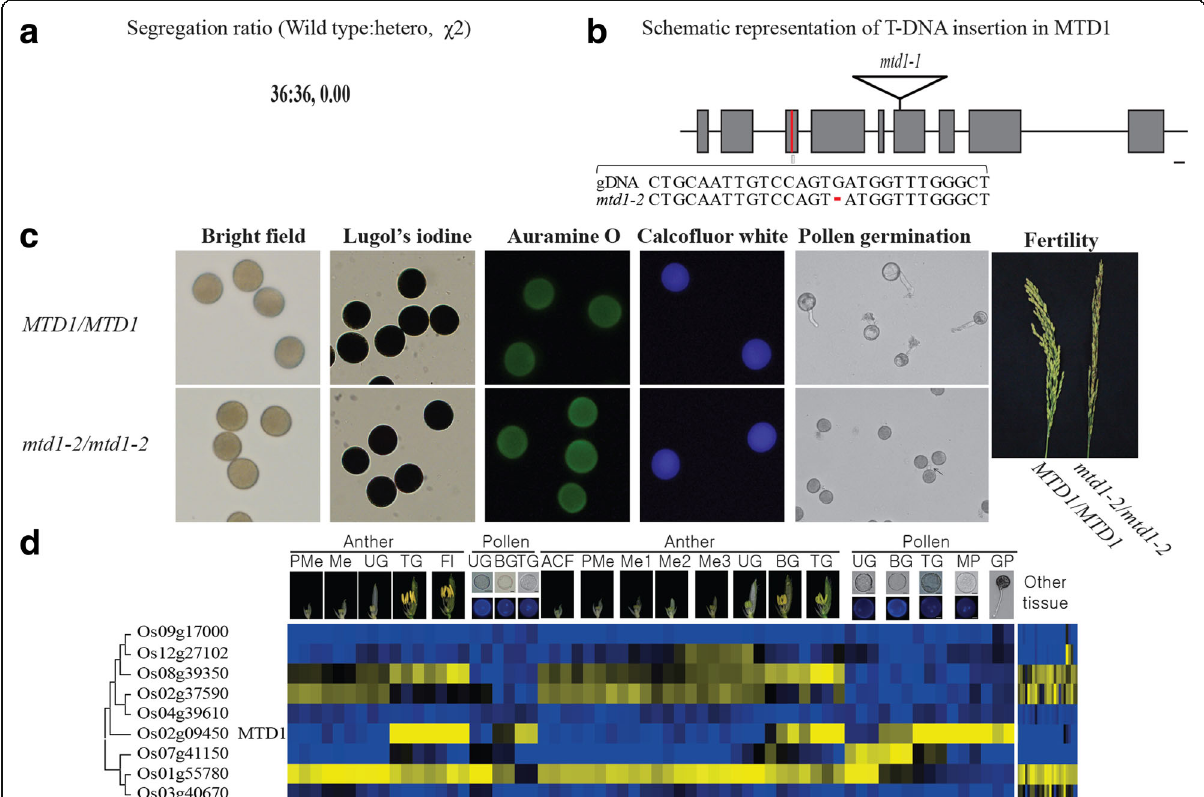
Fig. 6 Estimation of functional dominancy by MTD genes through phylogenomic analysis ( a ) segregation ratios of heterozygotes and wild-type segregants in mutants of MTD1 by T-DNA insertion, and results of Chi-square test ( χ 2 ). b Schematic view of MTD1 structure and mutated position by T-DNA insertions and deletion generated by CRISPR/Cas9. Grey boxes indicate exon; lines, UTR or intron; reverse triangles, T-DNA; red box, target region of CRISPR/Cas9. Genomic DNA sequences from wild type and gtd1 – 2 are shown. c Phenotypes of pollen grains from wild type and mtd1 – 2 . Germinated pollen and grains stained with Lugol ’ s iodine, auramine O, or calcofluor white were observed under bright field and fluorescence microscopes. Bar=20 μ m. Panicles at filling stage of wild type and mtd1 – 2 were observed. d Expression patterns according to developmental stages of pollen were analyzed using 22 microarray data from indica rice (5 stages for anthers, 3 for pollen) and 42 microarray data from japonica rice (8 stages for anthers, 5 for pollen). Anatomical meta-expression data from ROAD were used to check expression patterns in other tissues. ACF, archesporial cell-forming stage; BG, bi-cellular gametophyte stage; Fl, flowering stage; GP, germinating pollen; Me, meiotic stage; Me1, meiotic leptotene stage; Me2, meiotic zygotene-pachytene stage; Me3, meiotic diplotene-tetrad stage; MP, mature pollen stage; PMe, pre-meiosis; TG, tri-cellular pollen stage;